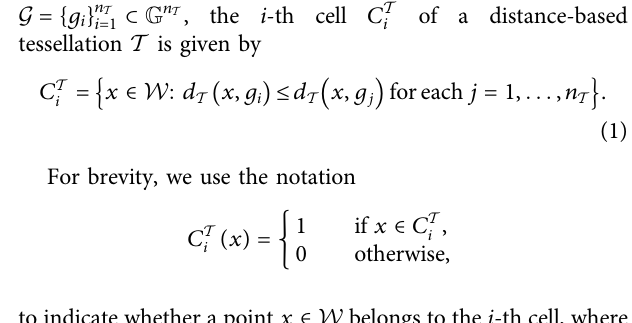
Frontiers in Materials |